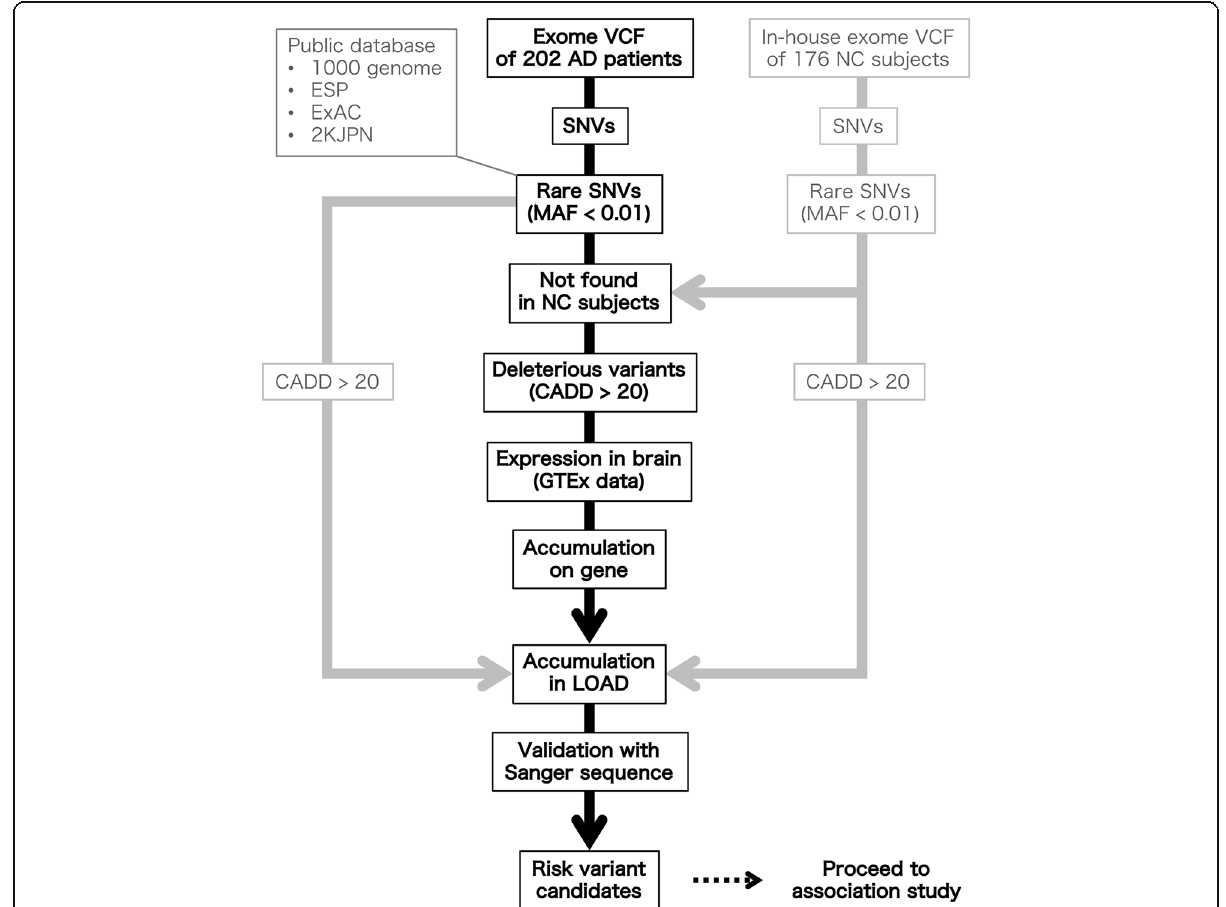
Fig. 1 Overview of the risk variant discovery